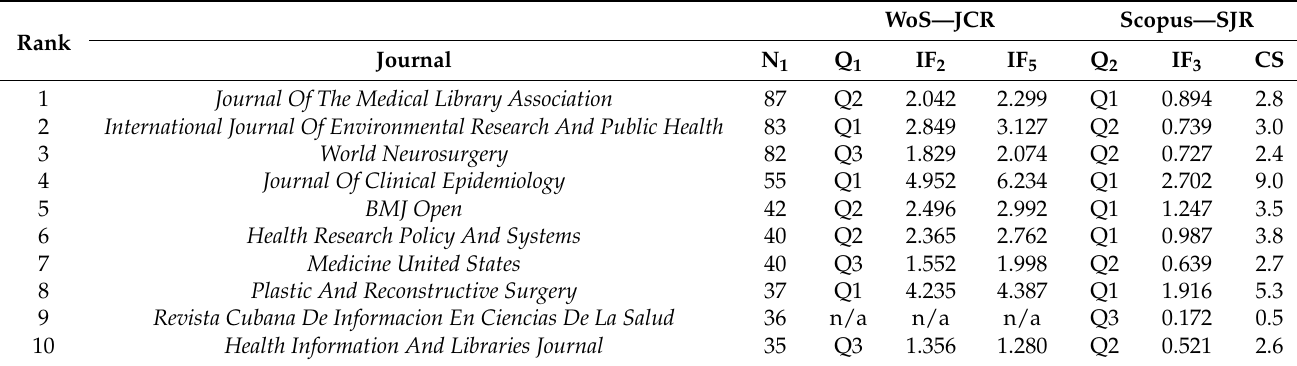
Table 13. Top 10 journals publishing articles on bibliometrics in the category of medicine and their main bibliometric source indices.